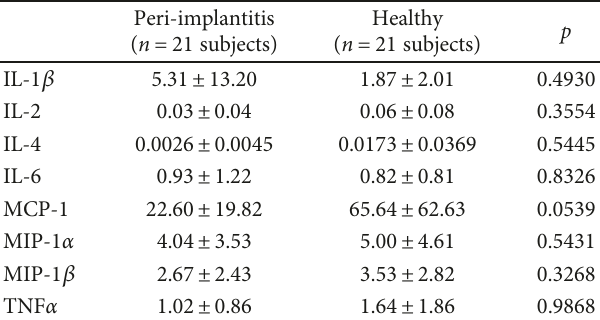
Table 3: Comparison of salivary marker levels (mean ± standard deviation) between the healthy and peri-implantitis groups. Student ’ s t -test and Mann – Whitney test ( p > 0 05 ).